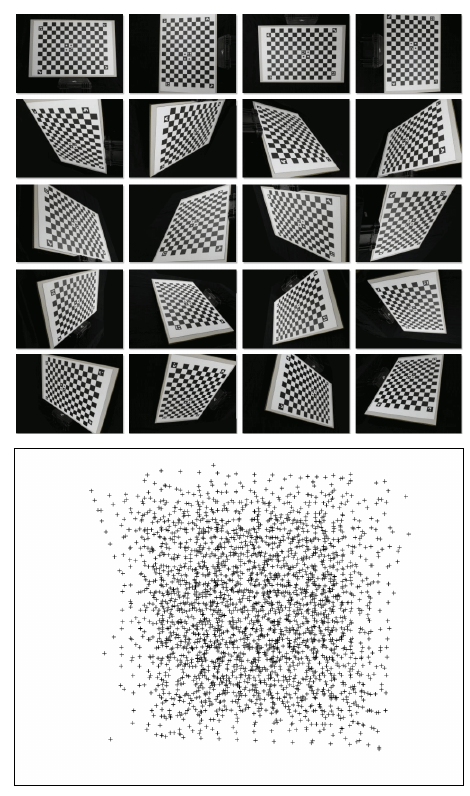
Figure 5: Typical accumulated corner distribution (bottom) for poses with the restriction of a fully visible chessboard in each image